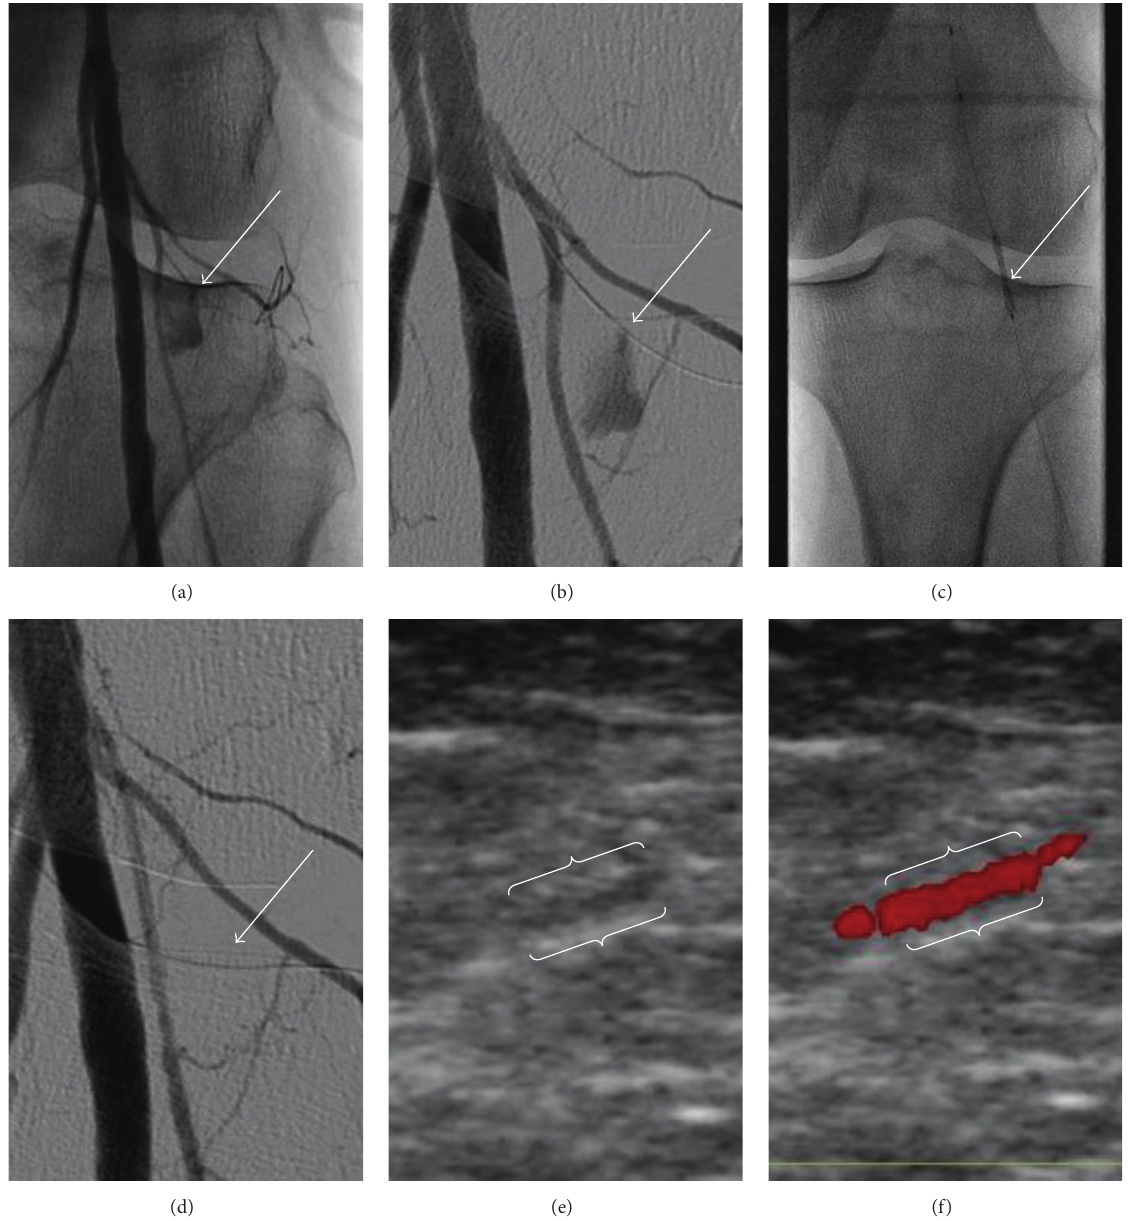
Figure 2: Perforation of a small side branch of the popliteal artery presumably by the 0.035 󸀠󸀠 Terumo guide wire (white arrow in (a)). A 0.014 󸀠󸀠